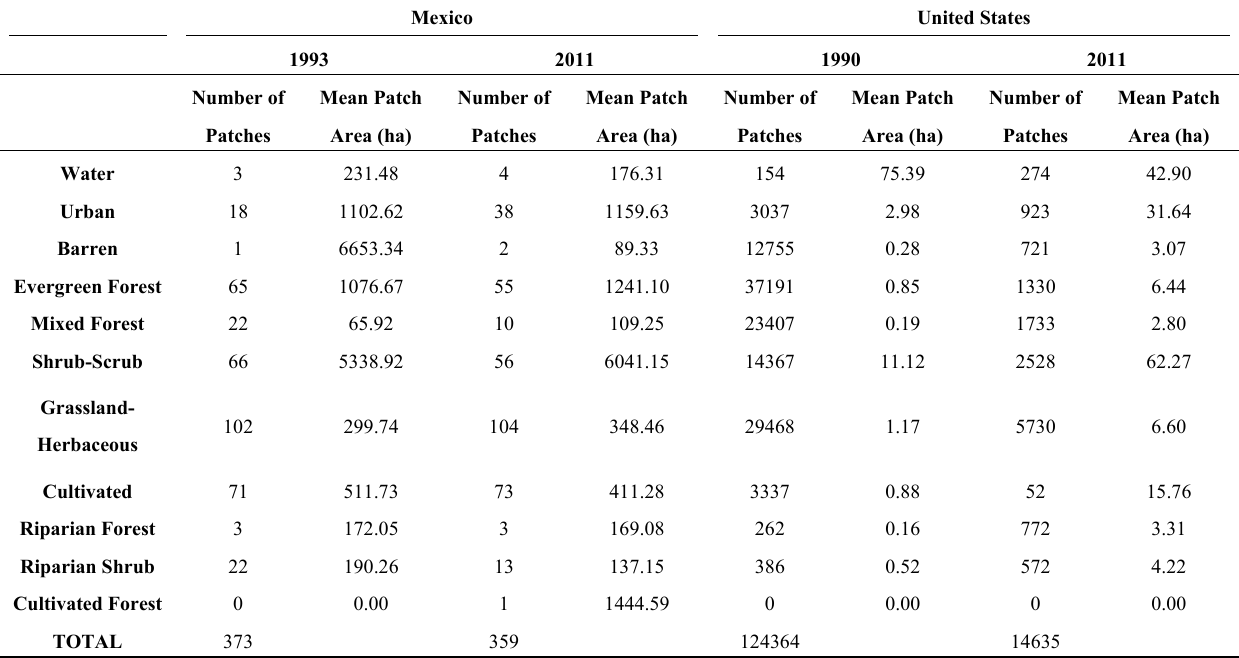
Table 6. Fragmentation metrics by LUVC and